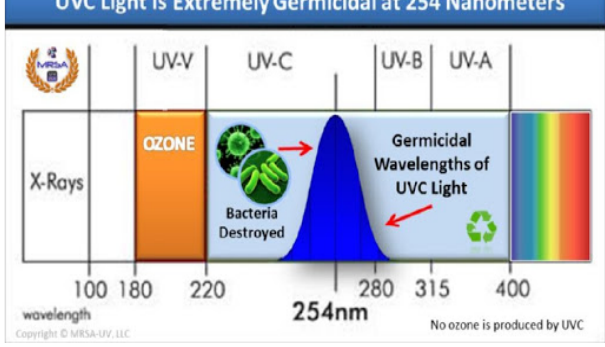
Figure 3. Electromagnetic Spectrum of